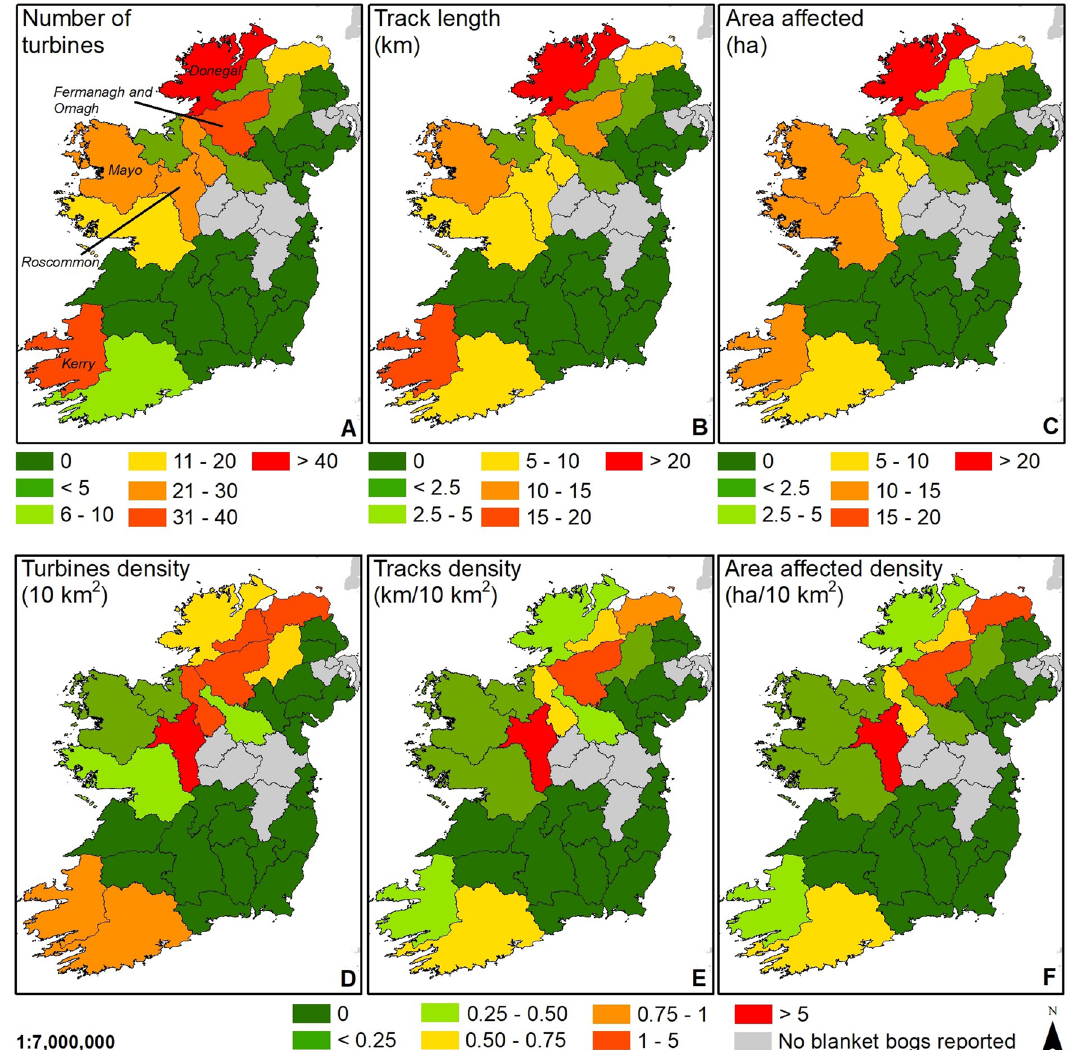
Figure 3. The extent of windfarm developments across the island of Ireland on blanket bog habitat 7130 at county level for the Republic of Ireland and intact or pool complex after blanket bog visual assessment for peatlands on Northern Ireland. ( A ) Total turbines on blanket bog habitat by county. ( B ) Tracks length on blanket bog habitat by county. ( C ) Total area affected by wind farm developments on blanket bog habitat by county. ( D ) Density of turbines by 10 km 2 of blanket bog habitat by county. ( E ) Density of tracks by 10 km 2 of blanket bog by county. ( F ) Density of area affected by wind farm developments by 10 km 2 of blanket bog habitat by county. Dataset for blanket bog habitat 7130 : Ireland 36 . Dataset for peatlands : Northern Ireland 38 . Map created in ArcGIS